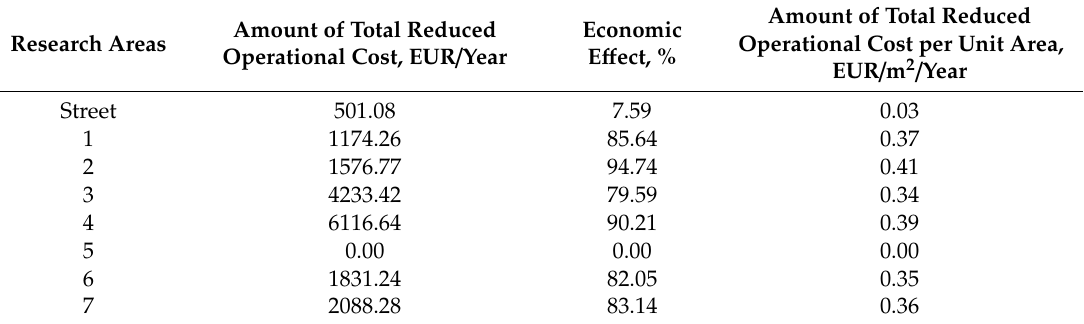
Table 3. Economic effects related to the implementation of the NBS. Table 3. Economic e ff ects related to the implementation of the NBS.